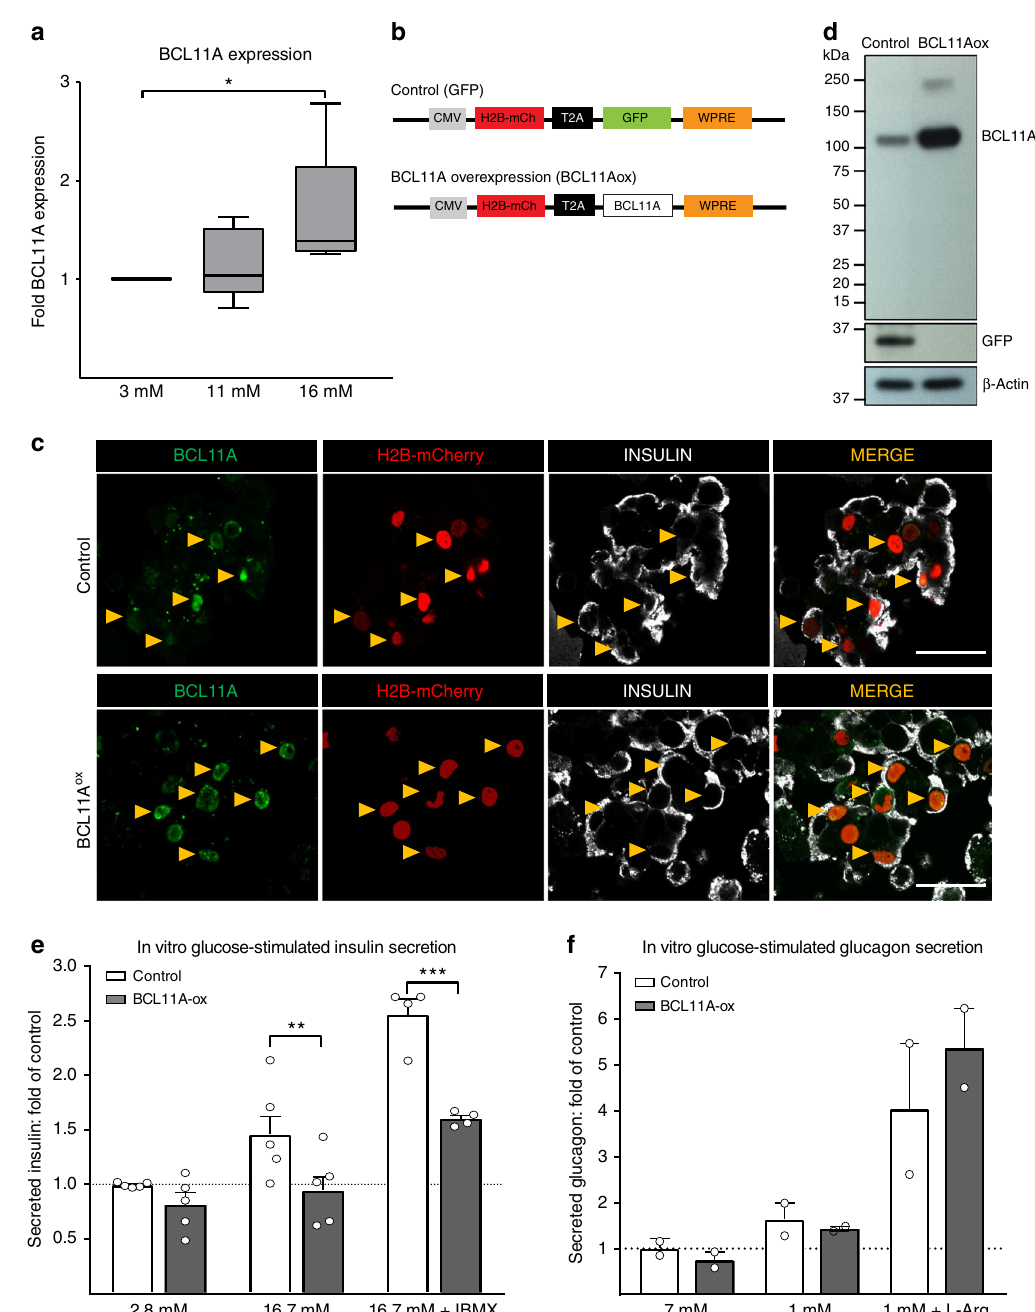
Fig. 3 BCL11A expression in human islets is glucose responsive and inhibits insulin secretion. a BCL11A mRNA expression in human islets cultured at 3, 11 and 16 mM glucose for 5 days ( n = 5). b Schematics of lentiviral construct used to overexpress BCL11A and control expressing GFP. c Immunohistochemical staining of human pseudo islets with BCL11A (green), Insulin (white) and H2B-mCherry (red) along with 4,6-diamidino-2- phenylindole (DAPI) nuclear staining (blue), scale bar = 20 µ m. d Immuno blots showing the overexpression of BCL11A or GFP in relation to β -actin loading control ( n = 2) in human pseudo islet lysates. e In vitro glucose-stimulated insulin secretion from human pseudo islets after transduction with control (white bars) or BCL11ox (black bars) lentiviral vectors. Secreted insulin is normalized to insulin content, ( n = 5). f In vitro glucose-stimulated glucagon secretion from human pseudo islets after transduction with control (white bars) or BCL11ox (black bars) lentiviral vectors. Secreted glucagon is normalized to glucagon content, ( n = 2). Original scan of blots are shown in Supplementary Figure 3. The data presented as mean, error bars represent the standard error, and two-tailed t tests were used to generate p values. * p < 0.05, ** p < 0.01, *** p < lentivirus expressing GFP (Fig. 4b, c). qRT-PCR con fi rmed the independent experiments). Pearson correlation analysis followed appropriate enrichment and depletion of each cell type in the by unsupervised hierarchical clustering of the sequenced librar- puri fi ed GFP + cell fractions (Supplementary Fig. 4c), and also ies (Fig. 4e) revealed close clustering between control and con fi rmed that human beta cells had over 50% reduction in BCL11A-kd samples from the same donor, re fl ecting the expected BCL11A mRNA levels compared to controls (Fig. 4d: n = 4 inter-donor variability we have previously reported 20 . We used